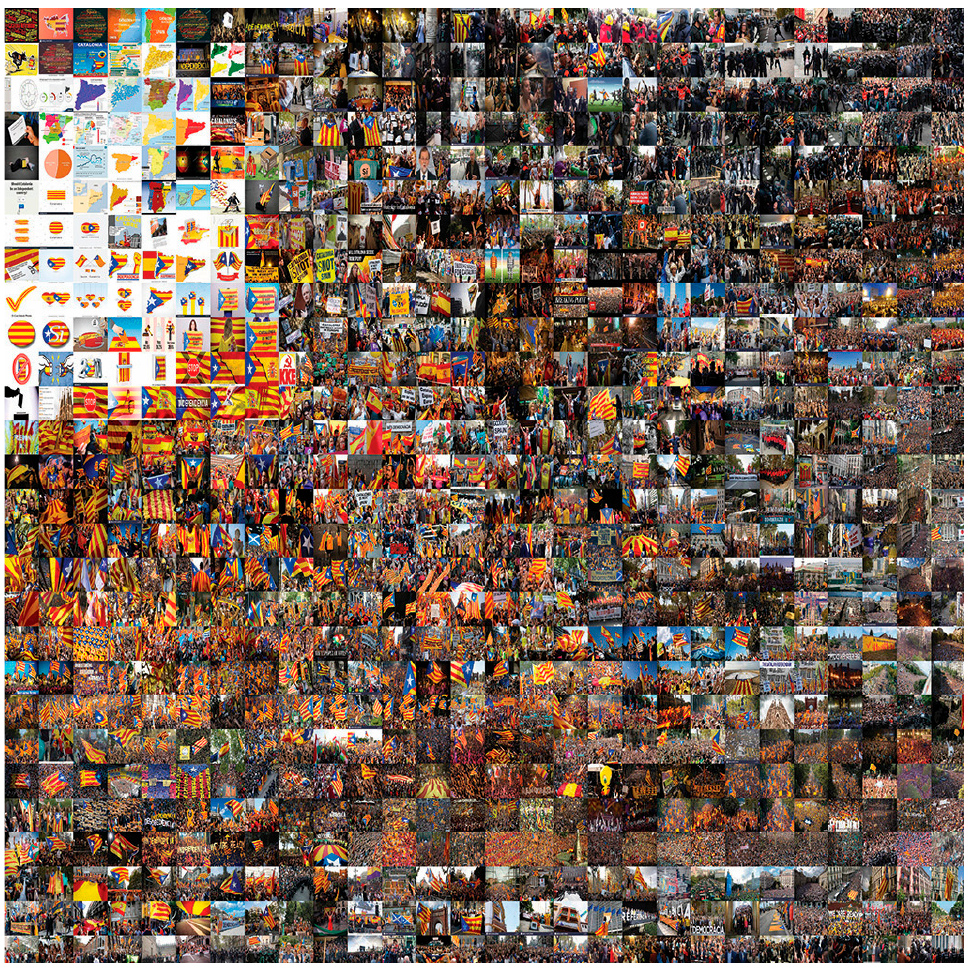
Figure 9. Digital image containing 800 photographs of demonstrations in Catalonia, ordered using the ResNet-50 convolutional neural network (1 × 1 m). © Pilar Rosado.